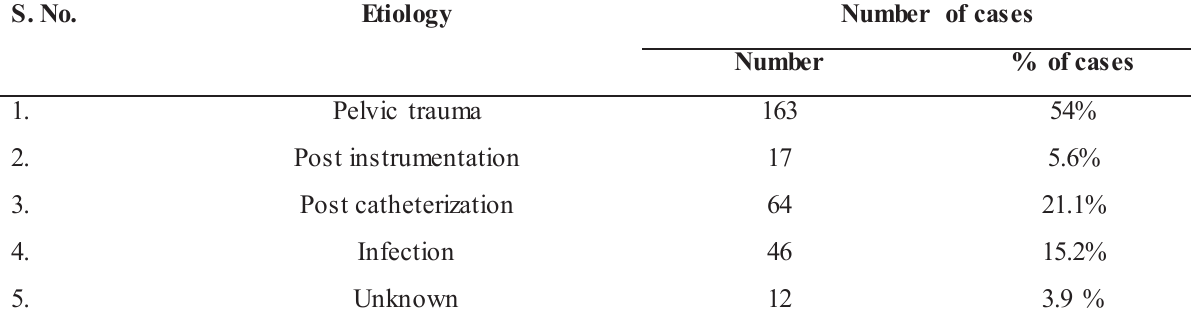
Table 3 - Various etiologies encountered. S.